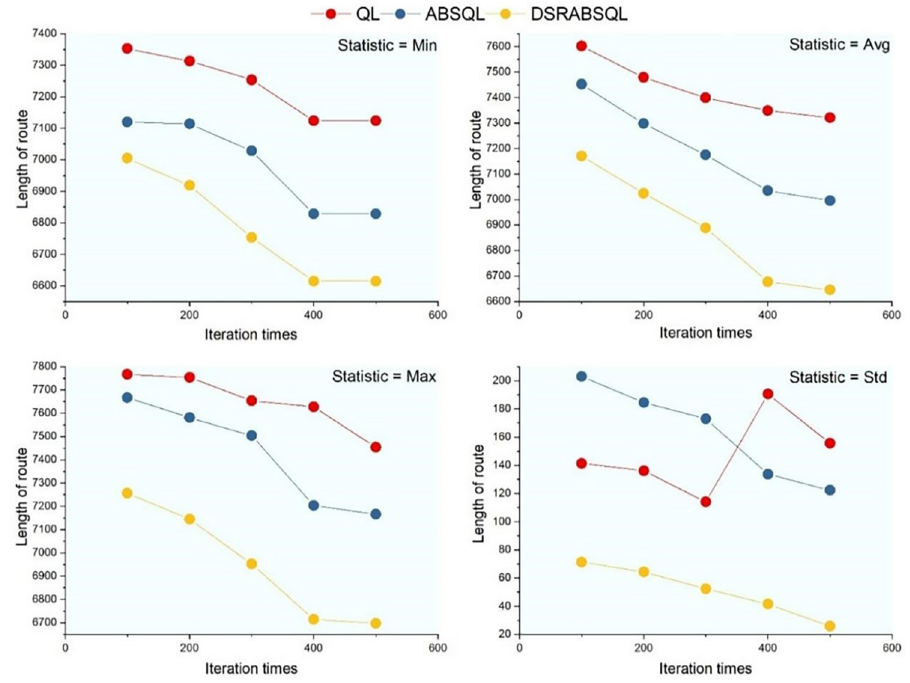
Fig 7. min , avg , max and S td of ch150 obtained by three